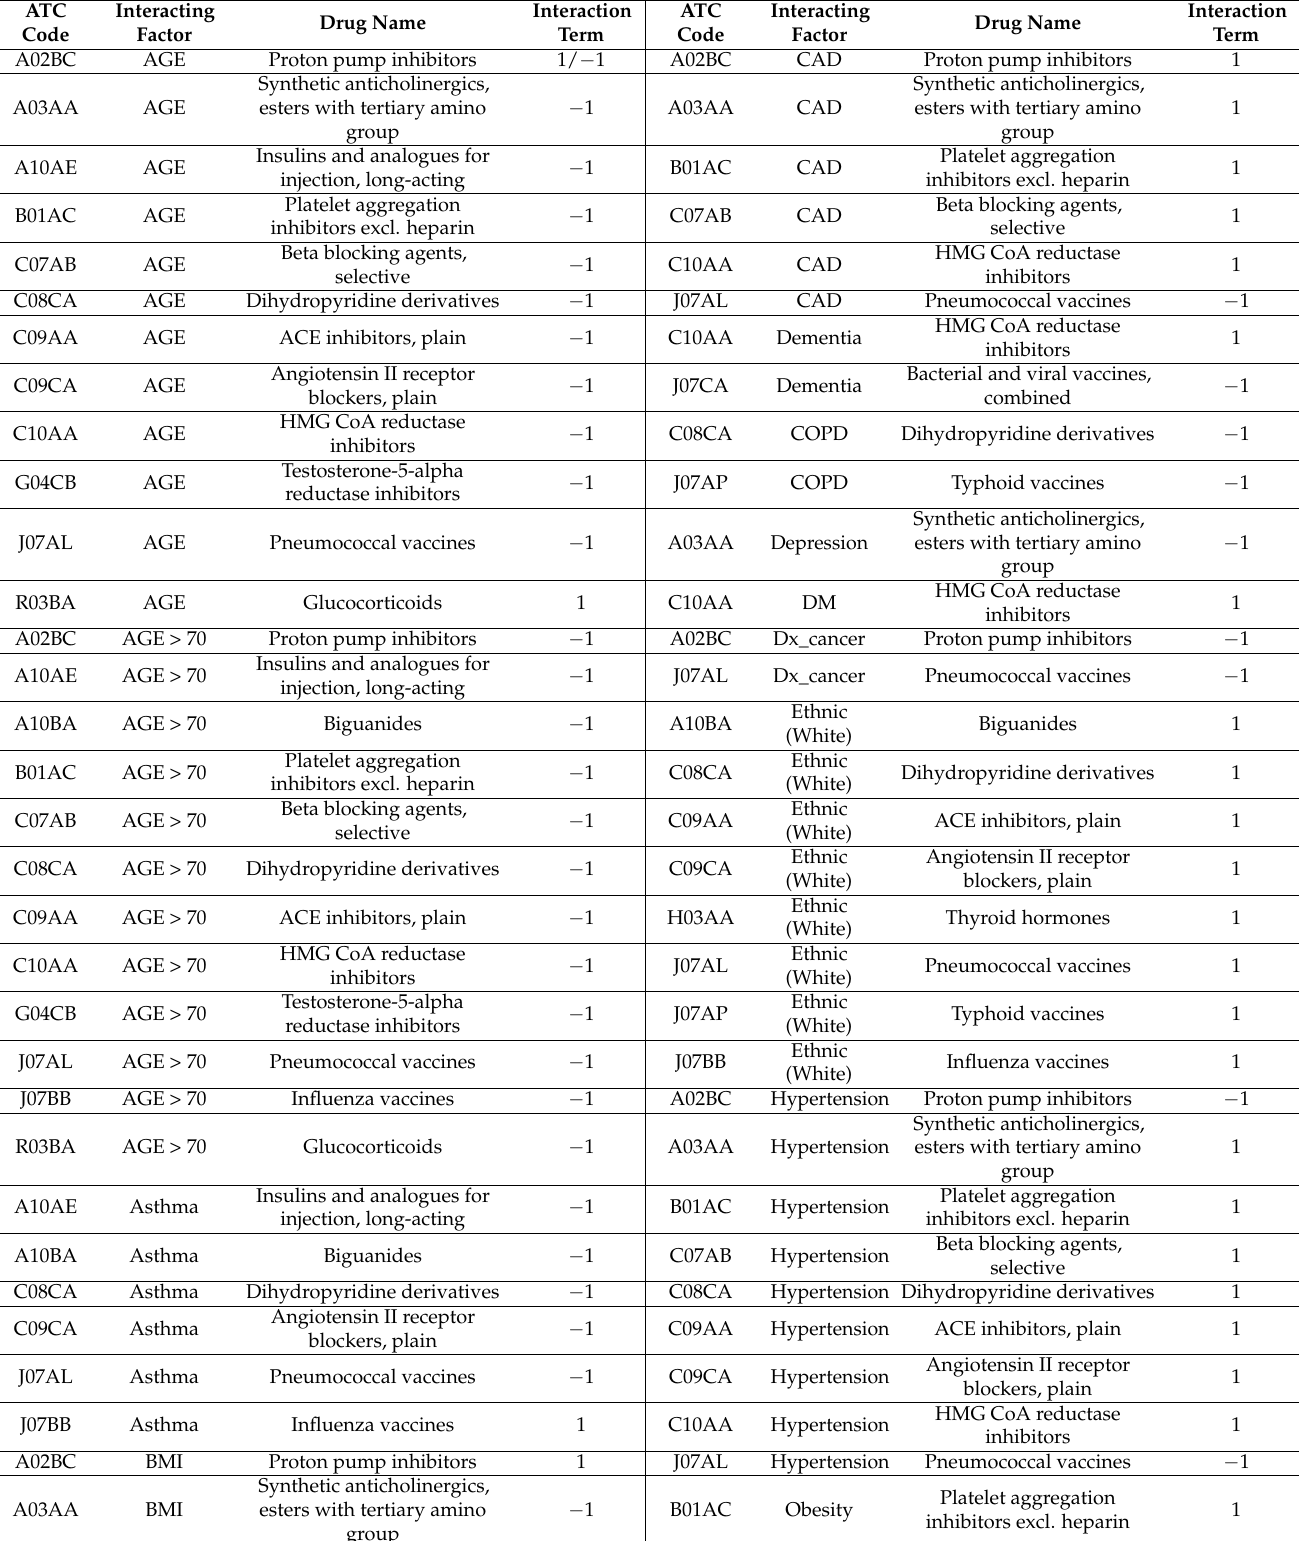
Table 8. Summary of interaction analysis, showing pairs of variables with significant interactions (FDR < 0.2). ATC